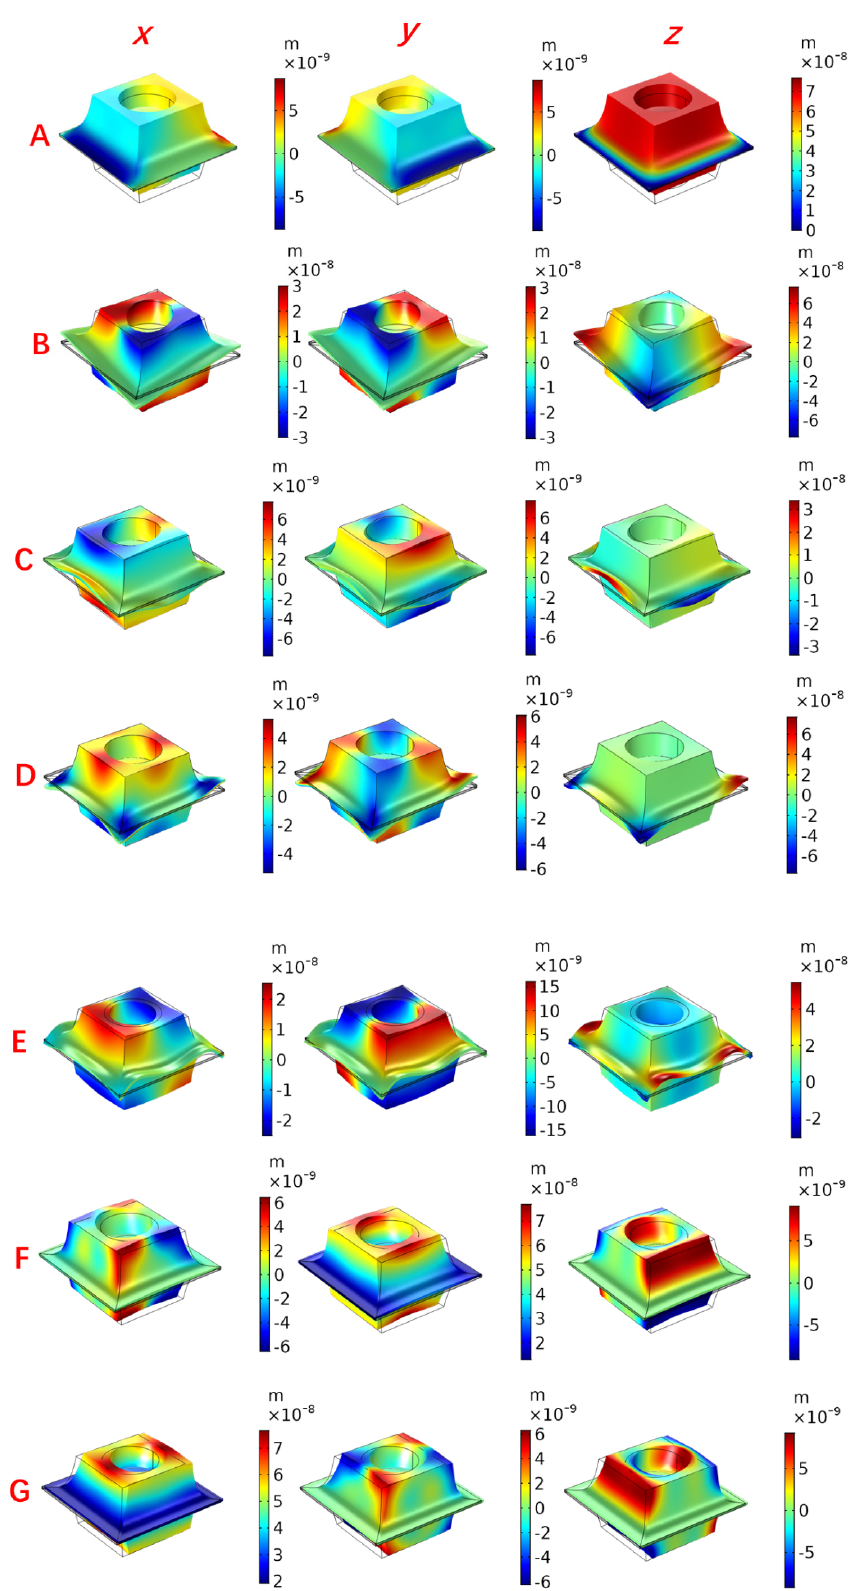
Figure 5. Displacement components of the eigenmodes at the ( A – G ) points in the dispersion curves in the x , y , and z directions. Table 2. Range of complete band gaps of the phononic crystal.